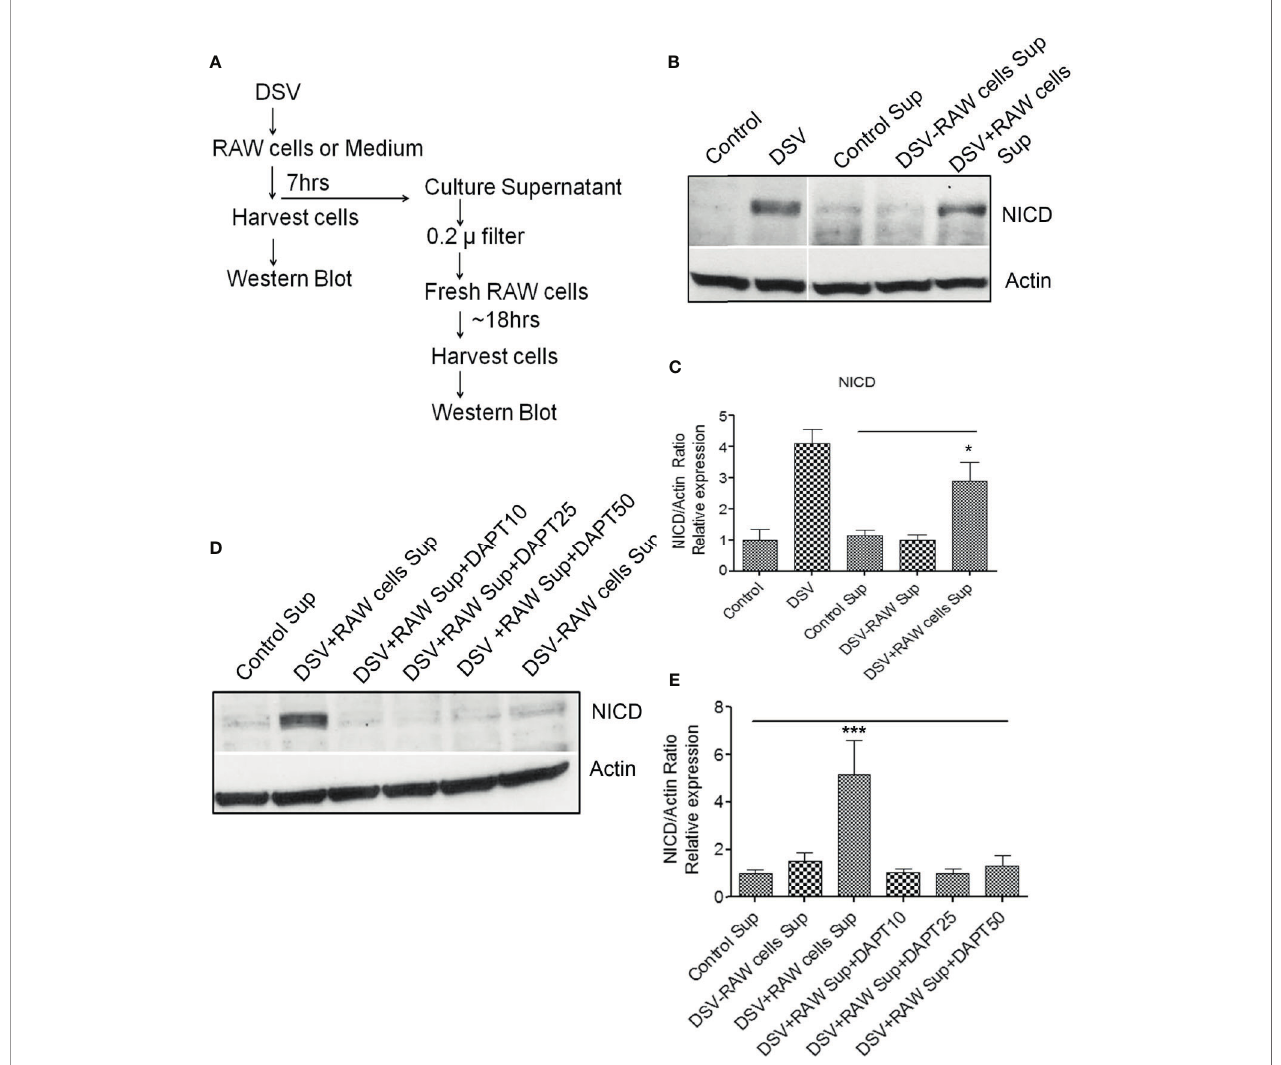
FIGURE 7 | Paracrine activation of Notch in recipient cells by culture supernatant of DSV-treated RAW cells (A) Flow chart of the experimental strategy to examine the paracrine effects of DSV-Notch signaling on uninfected target cells. See Figures 6 . (B) 8x10 5 cells were plated the day before infection. Cells were infected with DSV (MOI 20) for 7 hours. Culture supernatants were collected and the infected cells were harvested and lysed. Control Sup, DSV-RAW cell sup, or DSV+RAW cell sup was passed through a 0.2 µm fi lter and added to a fresh plate of uninfected recipient cells overnight. The following day, the recipient cells were harvested and lysed. Fifty m g of protein lysate was separated on SDS-PAGE and analyzed for NICD expression by Western blotting. Actin was used as a loading control. (C) Quanti fi cation of Western blots. Blots were quanti fi ed with ImageJ by analyzing the ratio of protein of interest/Actin. Data represents Mean ± SEM from at least three independent experiments. One-way ANOVA was used to determine the statistical signi fi cance. Values were compared to control sup, with a post-hoc Dunnett ’ s test. *p < 0.05. (D) Same as in (A) but in this experiment, recipient cells were pre-treated with various concentrations of DAPT overnight. Medium was removed and replaced with either control sup, DSV- RAW cell sup or with DSV+RAW cell sup for overnight incubation. Fresh DAPT was again added to the cells along with the culture supernatants. (E) Quanti fi cation of Western blots. Blots were quanti fi ed with ImageJ by analyzing the ratio of protein of interest/Actin. Data represents Mean ± SEM from at least three independent experiments. One-way ANOVA was used to determine the statistical signi fi cance. Values were compared to control sup, with a post-hoc Dunnett ’ s test. ***p <